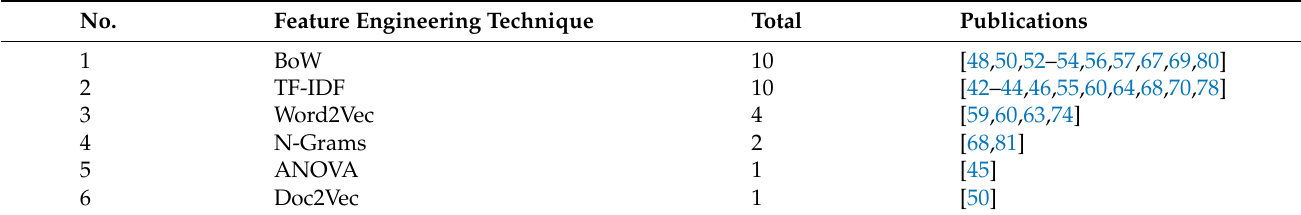
Table 4. Overview of the feature engineering